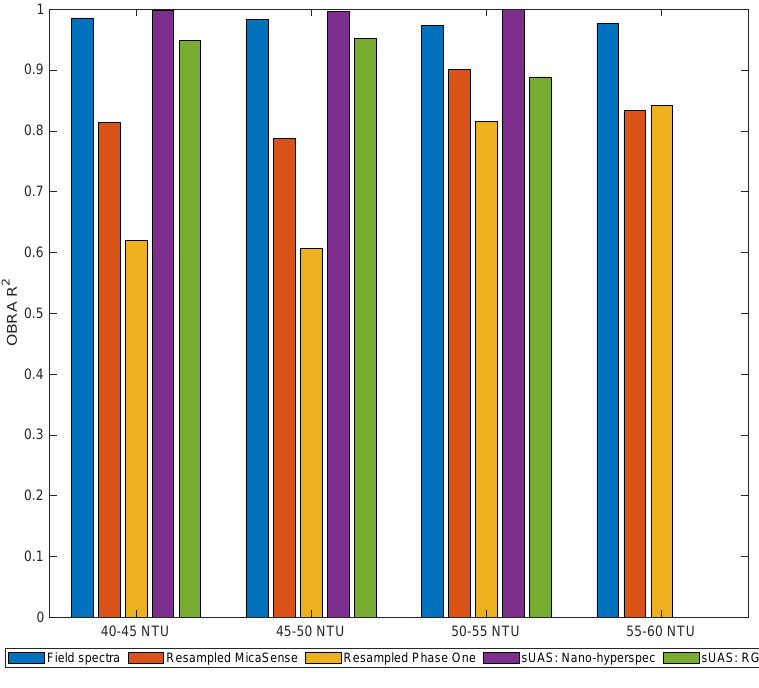
Figure 6. Summary of OBRA results for spectrally based dye concentration retrieval for varying levels of turbidity and types of